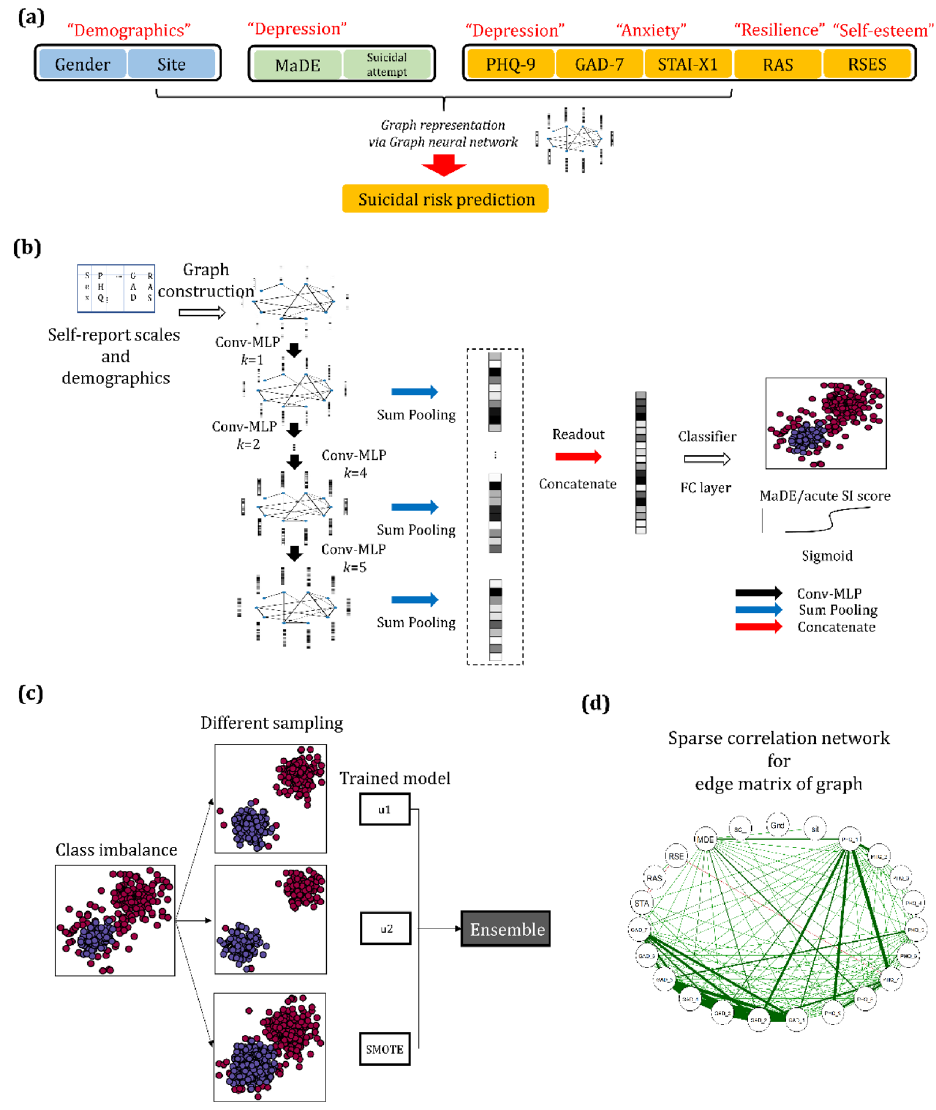
Figure 1. Overall architecture of a prediction model based on a graph isomorphism network (GIN): ( a ) Overall workflow for constructing the graph-structured dataset. A single subject corresponds to a single graph. ( b ) Graph constructed on multi-dimensional self-report questionnaires and clinico-demographic information, which were used as input node features and fed into five graph convolutional layers combined with MLP layers. In each layer, the graph representation is obtained after graph pooling, concatenated into a latent feature vector, and fed into a classifier using a fully connected layer to output a sigmoid prediction of MaDEs or acute SI score (0–1). ( c ) Three different GIN models with different subsampling strategies (i.e., GIN-SMOTE, GIN-u1, and GIN-u2) were ensembled to obtain the final model to overcome class imbalance. ( d ) Sparse correlation network for the edge matrix of the graph: pairwise correlation coefficients were obtained between the categorical variables of each node, representing each questionnaire item and subject information feature and were used as an edge matrix to construct a graph. All subjects share the same edge matrix to construct a graph. Note that PHQ-9 and GAD-7 show positive intra- and inter-correlations, whereas the RAS and RSES total scores are negatively correlated with the STAI-S total score. The sparsity of the graph edges was controlled by setting the threshold to 0.6. Note : Thickness of lines indicates degree of correlation coefficients in ( d ): i.e., a strong correlation between nodes is indicated by a thick line connecting the nodes. MaDE major depressive episode, SI suicidal ideation, SMOTE synthetic minority oversampling technique (u1 and u2) and under-sampling strategy (1 and